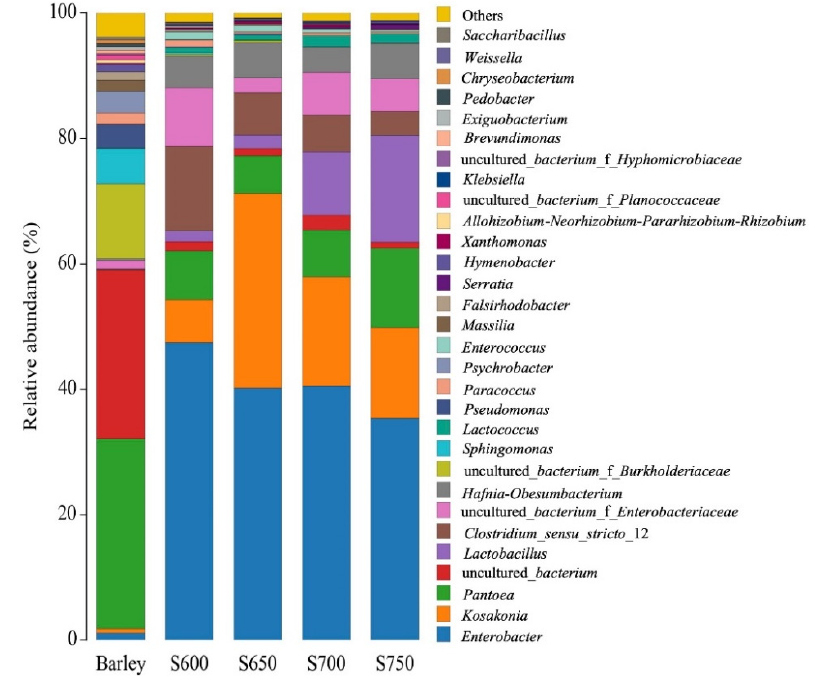
Figure 2. Bacteria community analysis of the top 30 bacterial genera from fresh barley and silages (n = 3). S600, S650, S700, and S750 represent silages densities of 600, 650, 700, and 750 kg/m 3 , respectively. Y-axis shows the genus; X-axis shows sample name.